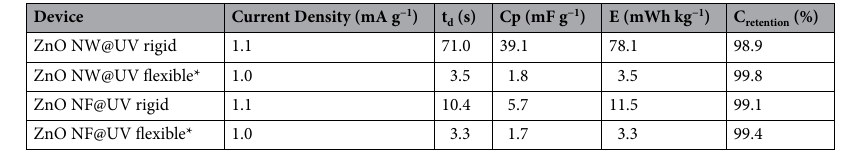
Table 1. Comparison of P-SC performance of rigid and flexible ZnO-based devices. *P-SC measurements of flexible devices were obtained at 30° concave bending.